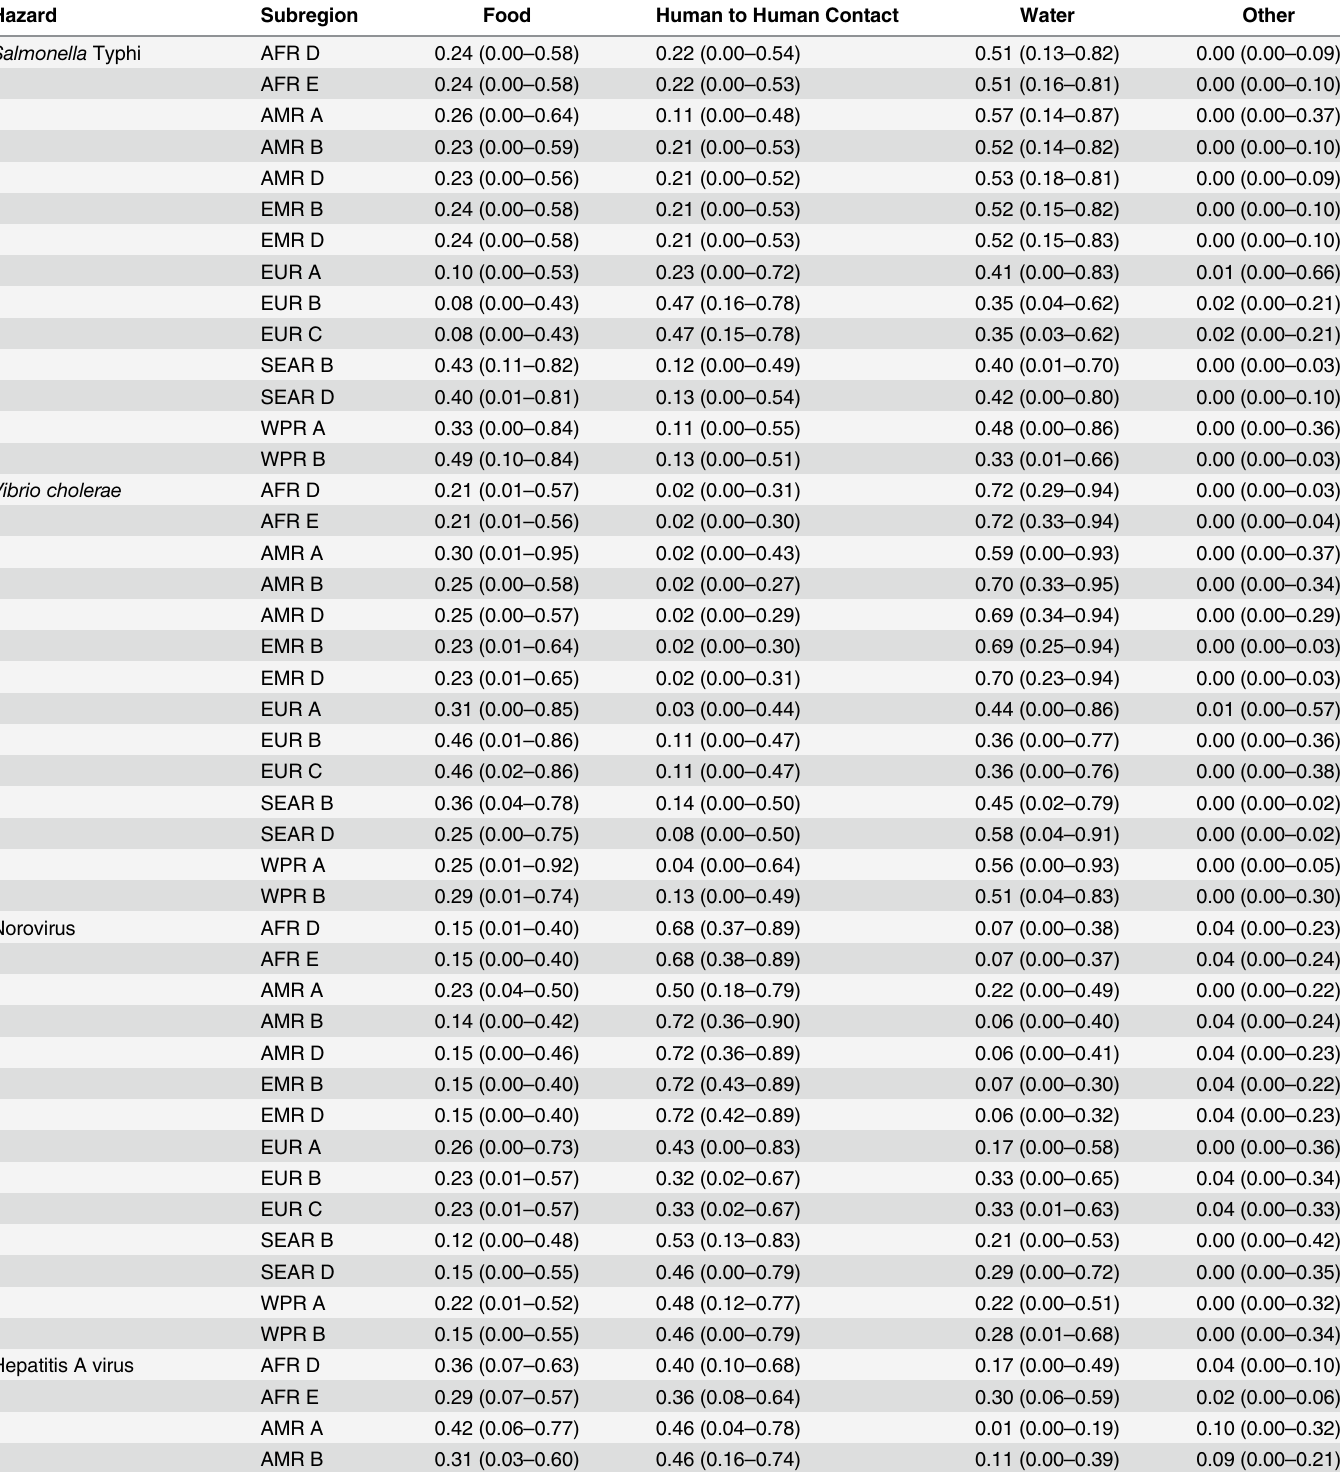
Table 7. Subregional estimates (median and 95% uncertainty interval) of the proportion of illnesses caused by Salmonella Typhi, Vibrio cholerae , Entamoeba histolytica , Norovirus, and Hepatitis A virus through each exposure